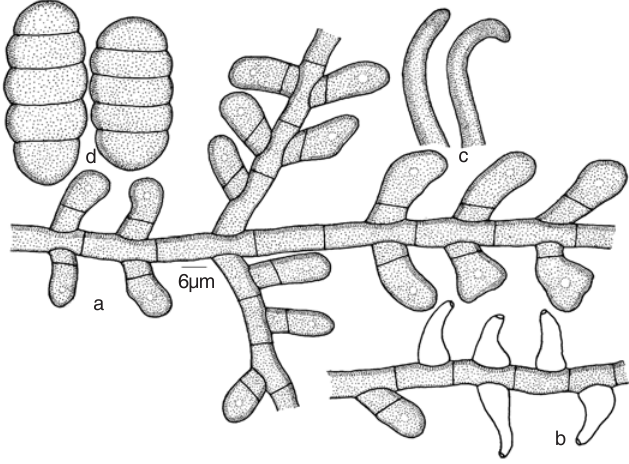
Figure 1. Meliola erumeliensis sp. nov. a - Appressorium; b - Phialide; c - Apical portion of the mycelial